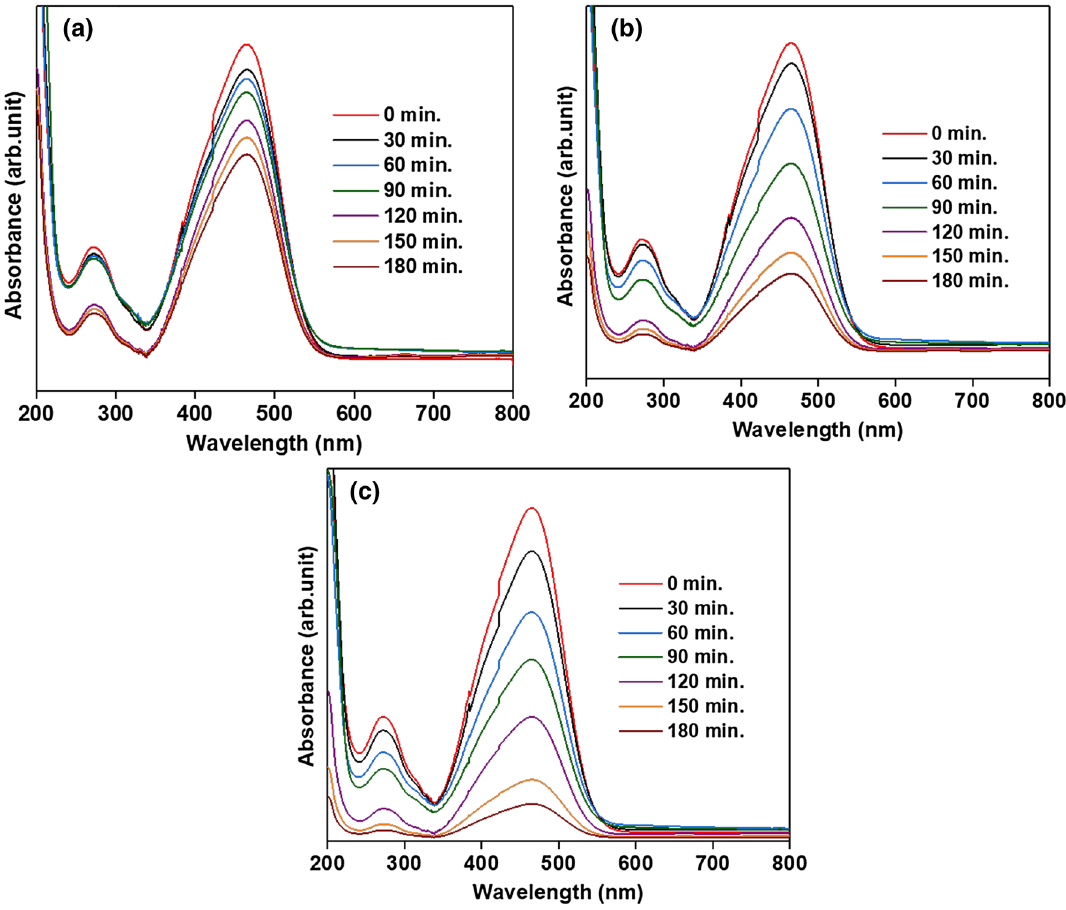
Fig. 7 UV–visible absorption spectra of MO degradation of samples a SnO